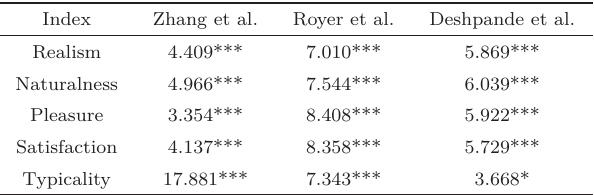
Table 1 Statistics of the difference between our method and others. In the form, ∗ ∗ ∗ means significance level 0.01, ∗∗ means